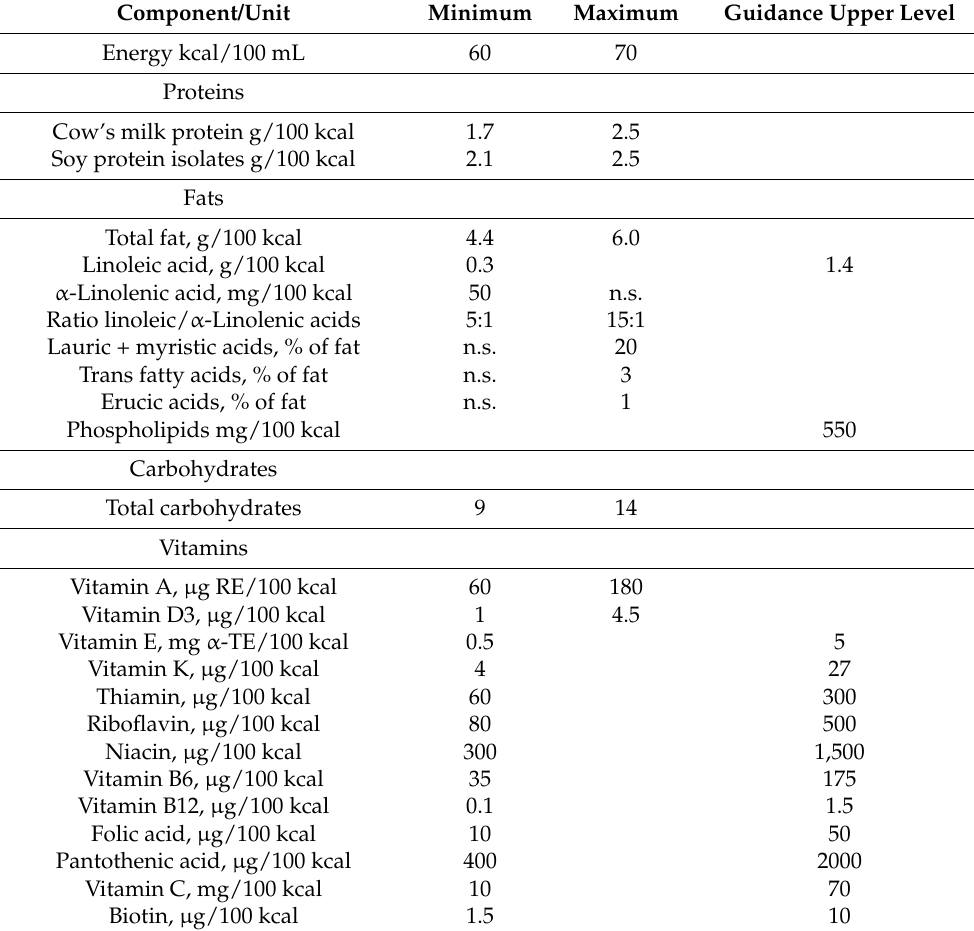
Table 3. Recommended composition of follow-up formula for older infants by an international expert group coordinated by the Early Nutrition Academy